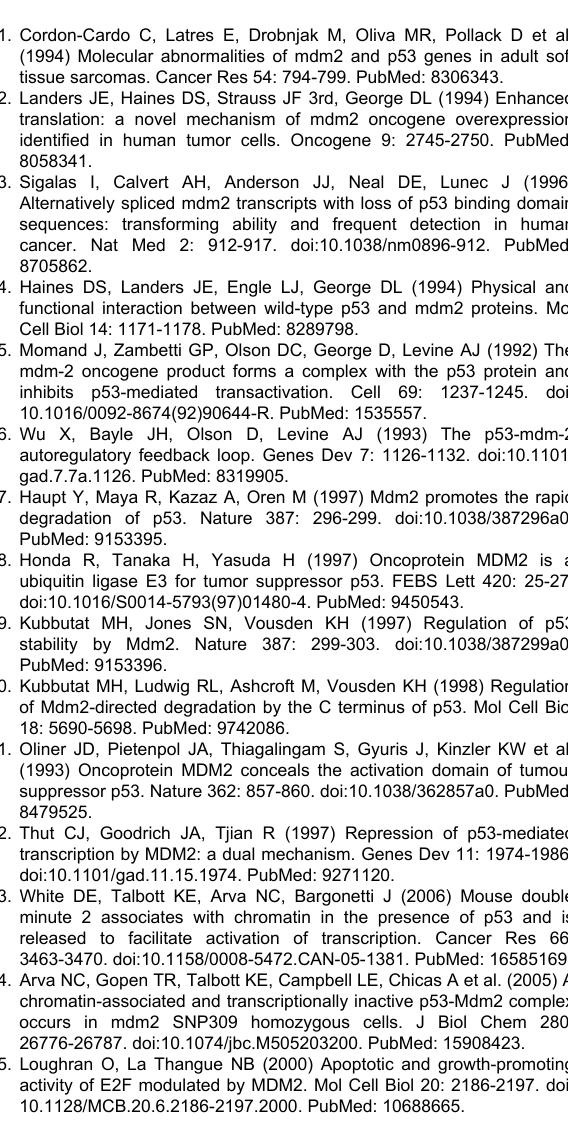
Table S1. List of proteins identified by LC/MS/MS and their protein sequence tags. After LC/MS/MS was carried out by the Memorial Sloan-Kettering Cancer Center Proteomics and Microchemistry Core Facility we used “scaffold analysis” of the identified peptides. We employed parameters with a